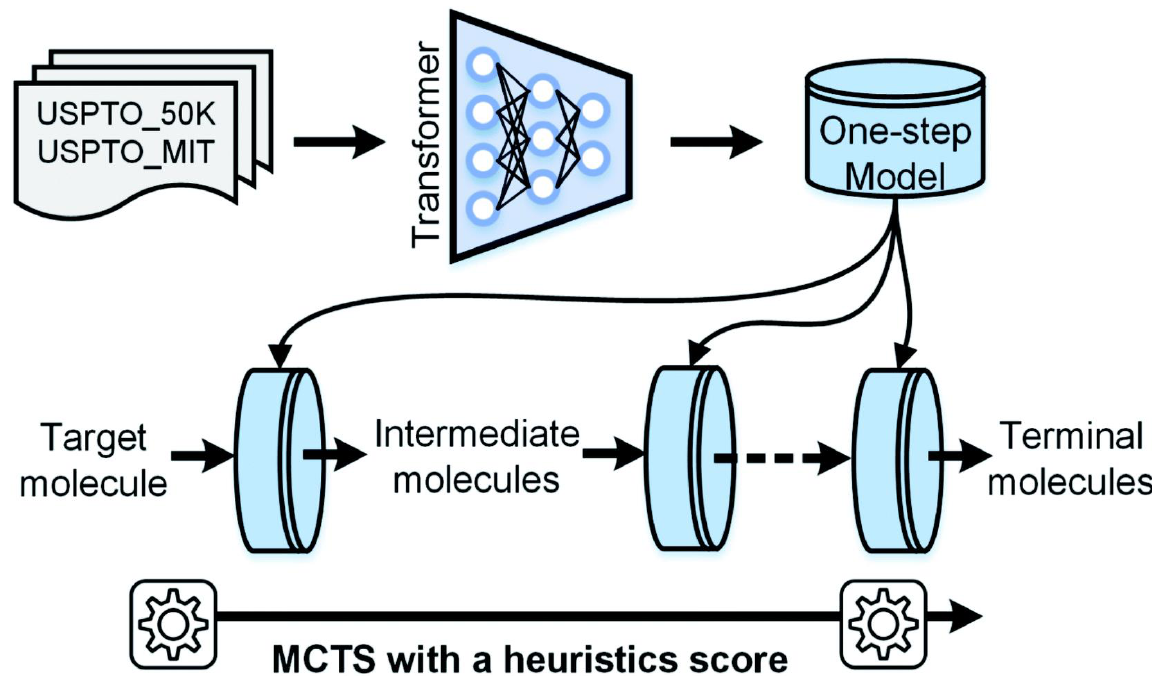
Figure 6. The workflow of AutoSynRoute. Reproduced with permission from [Lin, K.; Xu, Y.; Pei, J.; Lai, L], [Automatic retrosynthetic route planning using template-free models]; published by [Chem. Sci],